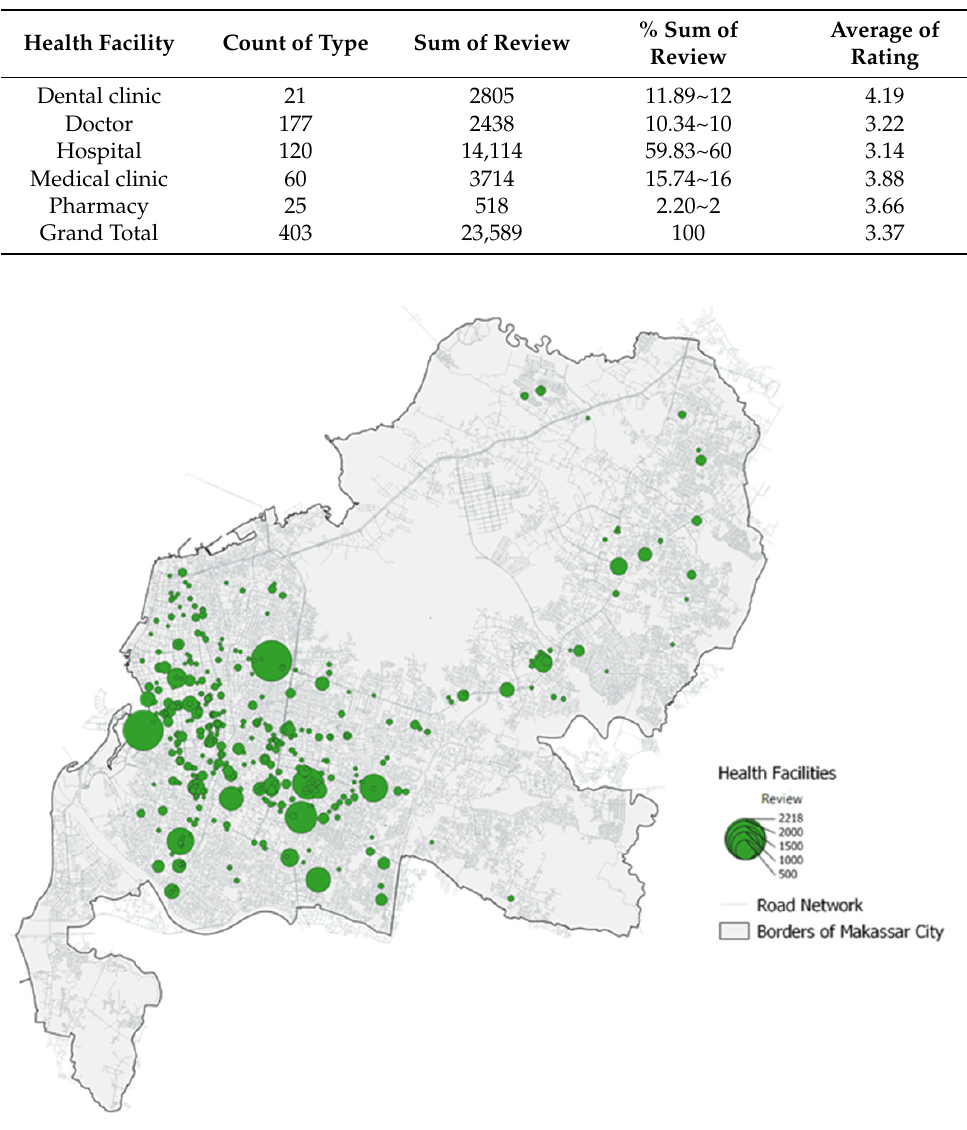
Table 7. Perceptions of Health Facility Services Based on POI Google.